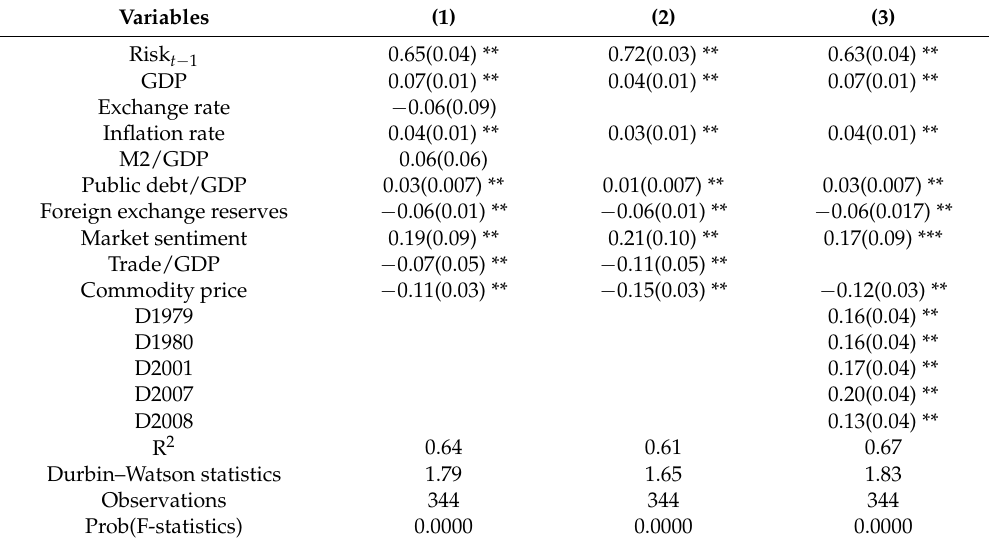
Table 4. Dynamic Fixed Effects estimation